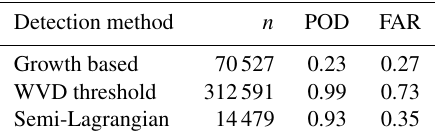
Table 3. Probability of detection (POD) and false alarm rates (FAR) for three different detection methods validated against observed GLM flashes ( n = 47096707). Growth based refers to the detec- tion of growing DCCs using the method described in Sect. 3.3. WVD threshold uses the threshold method developed by Müller et al. (2018). Semi-Lagrangian refers to the detection of anvil clouds connected to growing cores using the edge-based watershedding method described in Sect. 3.4. n